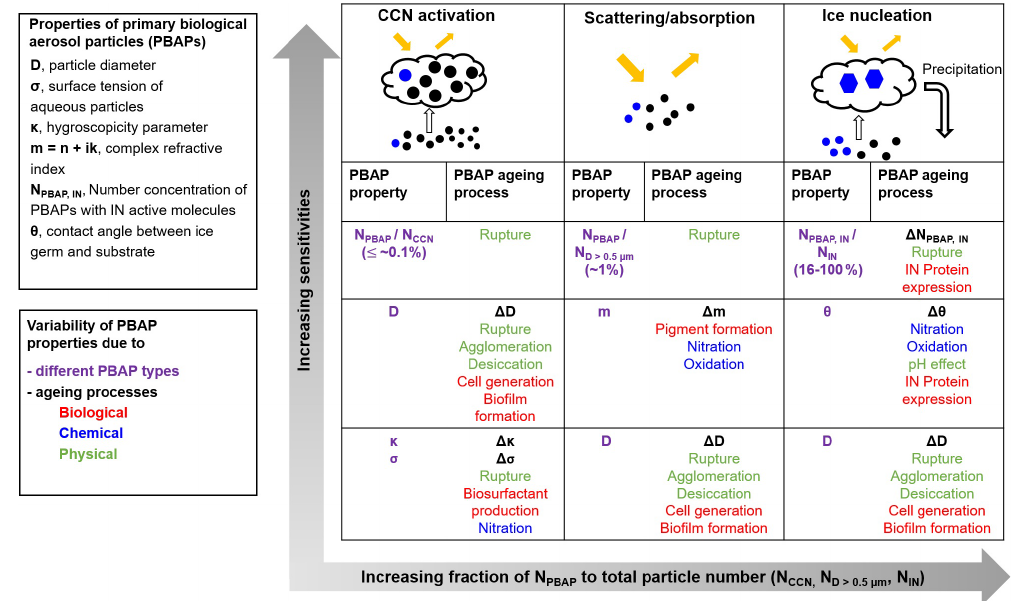
Figure 11. Schematic of PBAP types and ageing processes that affect their aerosol–cloud interactions and optical properties. The bottom arrow shows the increasing fraction of N PBAP to total particles ( N CCN , N D> 0 . 5µm , and N IN , respectively). The left arrow indicates the increasing sensitivity to PBAP properties as predicted based on our process model studies. The various properties might be modified by physical (green), chemical (blue), and biological (red) ageing